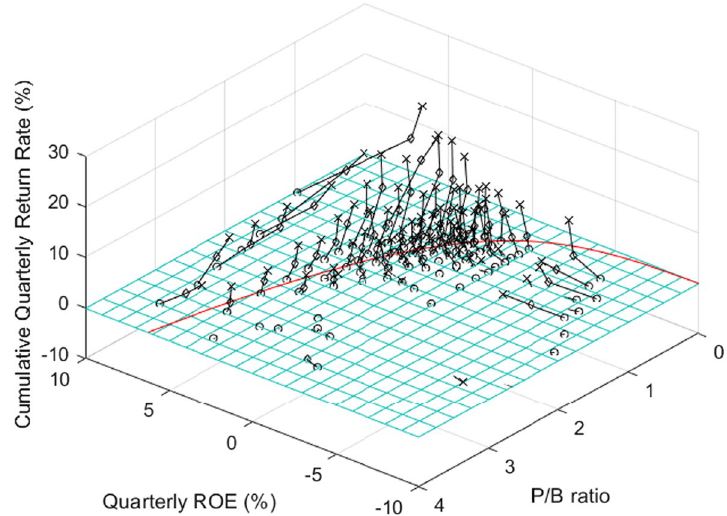
Fig. 23 The relationships among ROE, P/B, and cumulative quarterly return rates (circle, diamond, x‑mark: the data in the t, t 1, t 2 + +